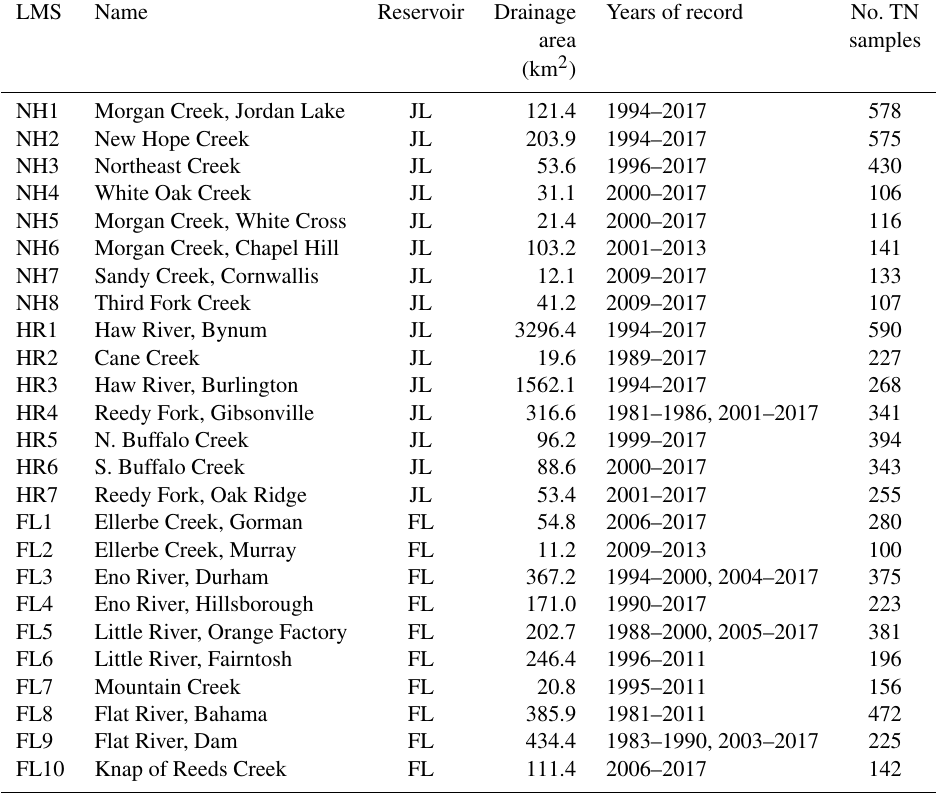
Table 1. Load monitoring stations (LMSs) located in the Jordan (JL) and Falls Lake (FL) basins along with their complete drainage areas. LMSs belong to either New Hope Creek (NH) or Haw River basins of JL or FL. Years of record correspond to time that loadings could be estimated (i.e., when daily flow and monthly water quality sampling was performed). The number of total nitrogen (TN) samples available is also